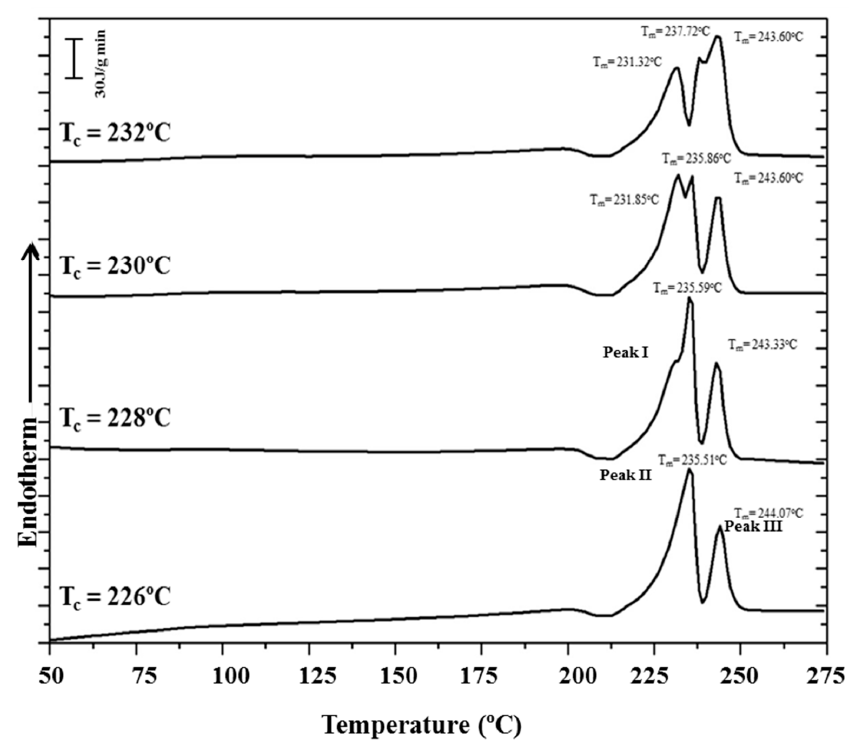
Figure 15. DSC traces corresponding to the heating run of samples isothermally crystallized at the indicated temperatures.